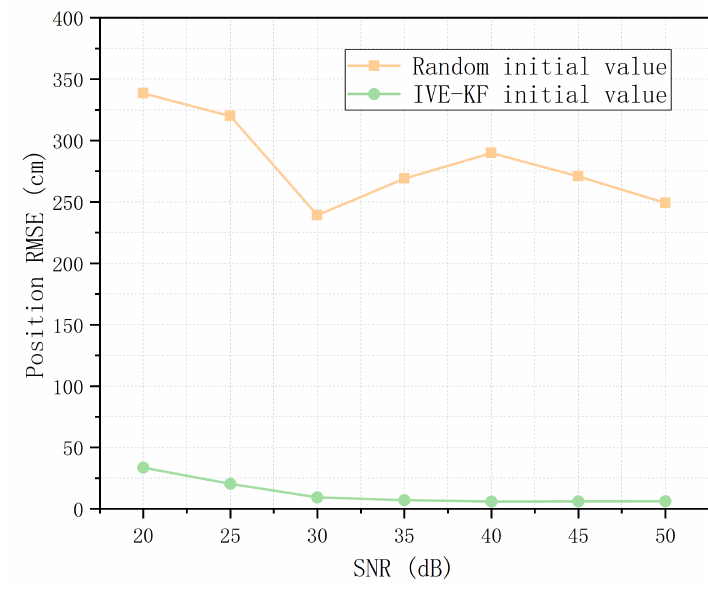
Figure 15. Root mean square error (RMSE) comparison of the position error between the IVE-KF algorithm and filter algorithm given random initial